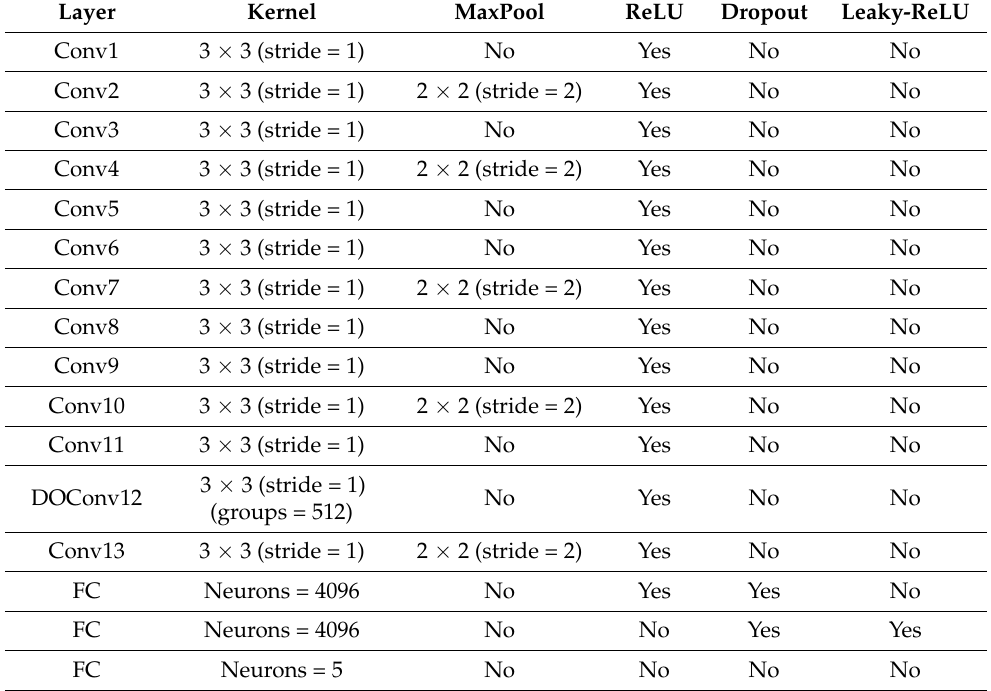
Table 2. The parameter settings of DGOVGG16 model.